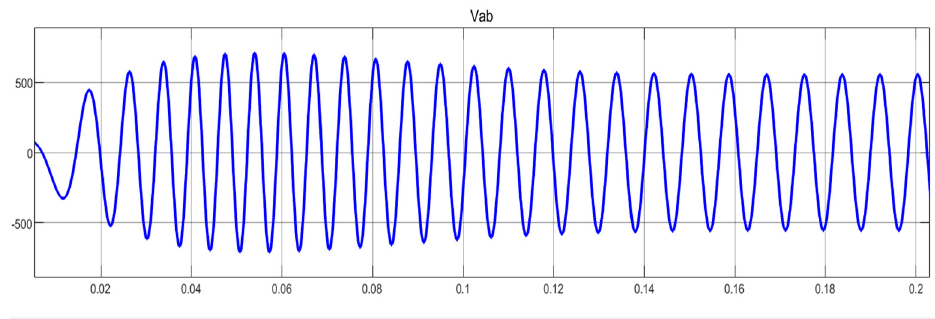
Figure 8. Line to line voltage V ab.